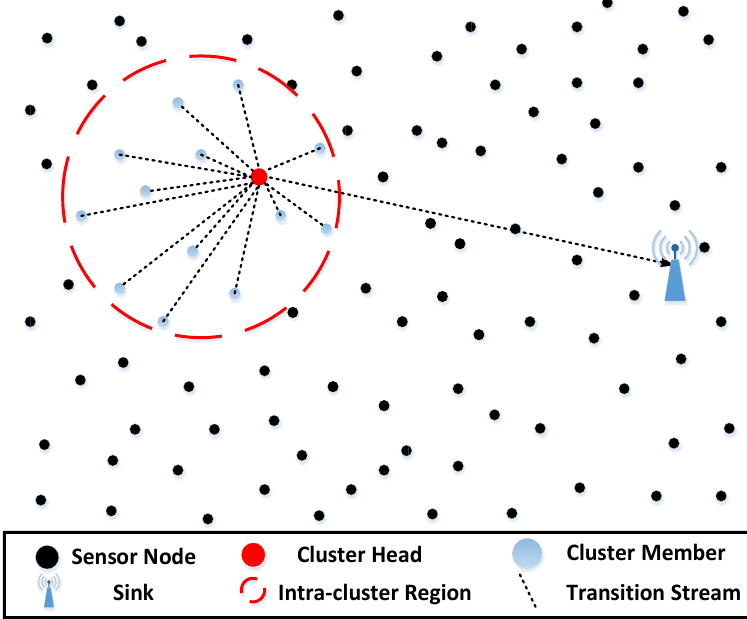
Figure 1. Basic cluster structure in the network.